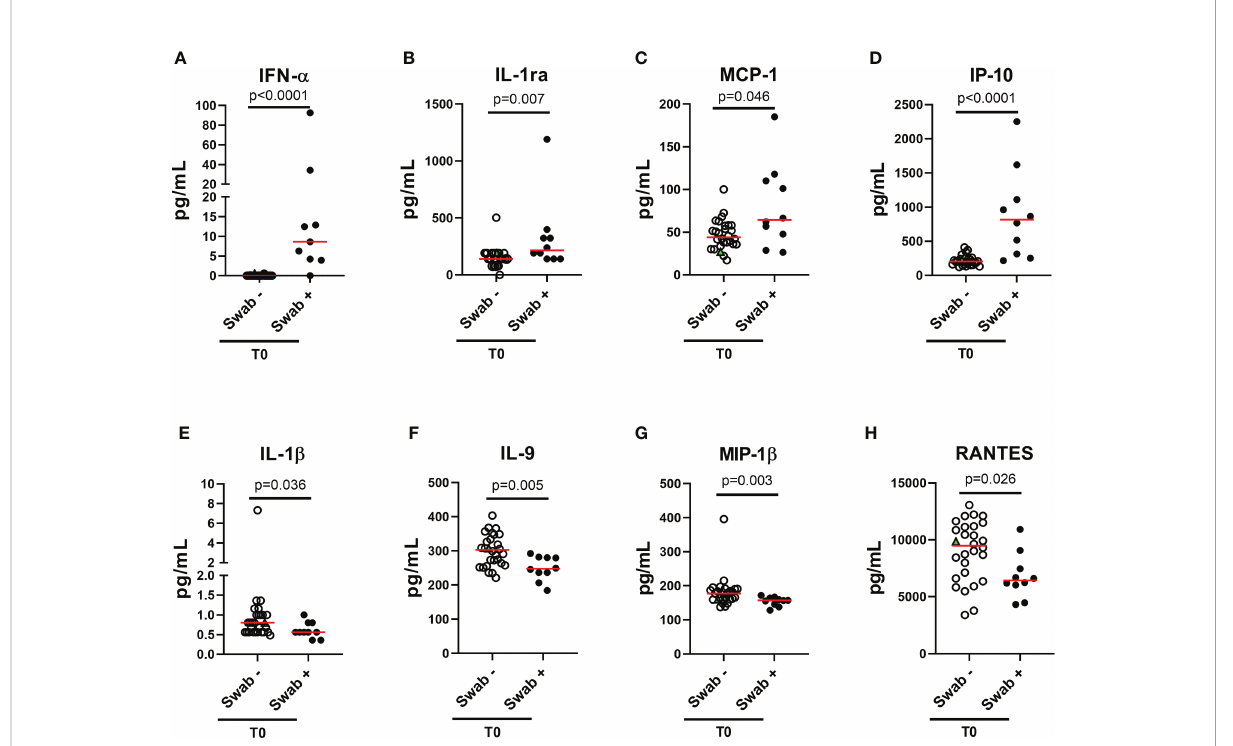
FIGURE 2 Plasmatic cytokines/chemokines modulated in household contacts at baseline. (A – H) Household contacts at T0 (n = 38) were strati fi ed according to the swab result: positive (n = 10) and negative (n = 28). Plasma harvested from unstimulated blood samples were tested for the detection of 27 cytokines/chemokines using the Bio-Plex Pro Human Cytokine 27-plex Assay and for the detection of IFN- a and- b by means of an automatic ELISA. Red horizontal lines indicate medians. The green triangle identi fi es the subject with a positive swab only at T1. Statistical analysis was performed using Mann-Whitney U test to compare swab positive and negative subjects. A p < 0.05 was considered signi fi cant. IL, interleukin; MCP, monocyte chemoattractant protein; MIP, macrophage in fl ammatory protein; IP, Interferon-gamma induced protein; RANTES, regulated on activation IFN,